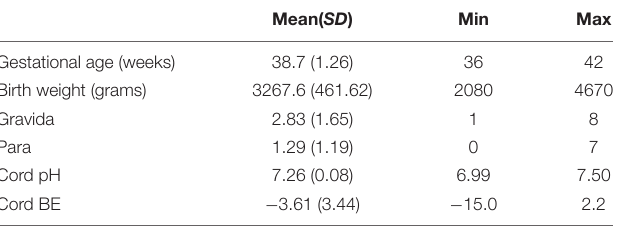
TABLE 2 | Sample characteristics I (continuous variables).